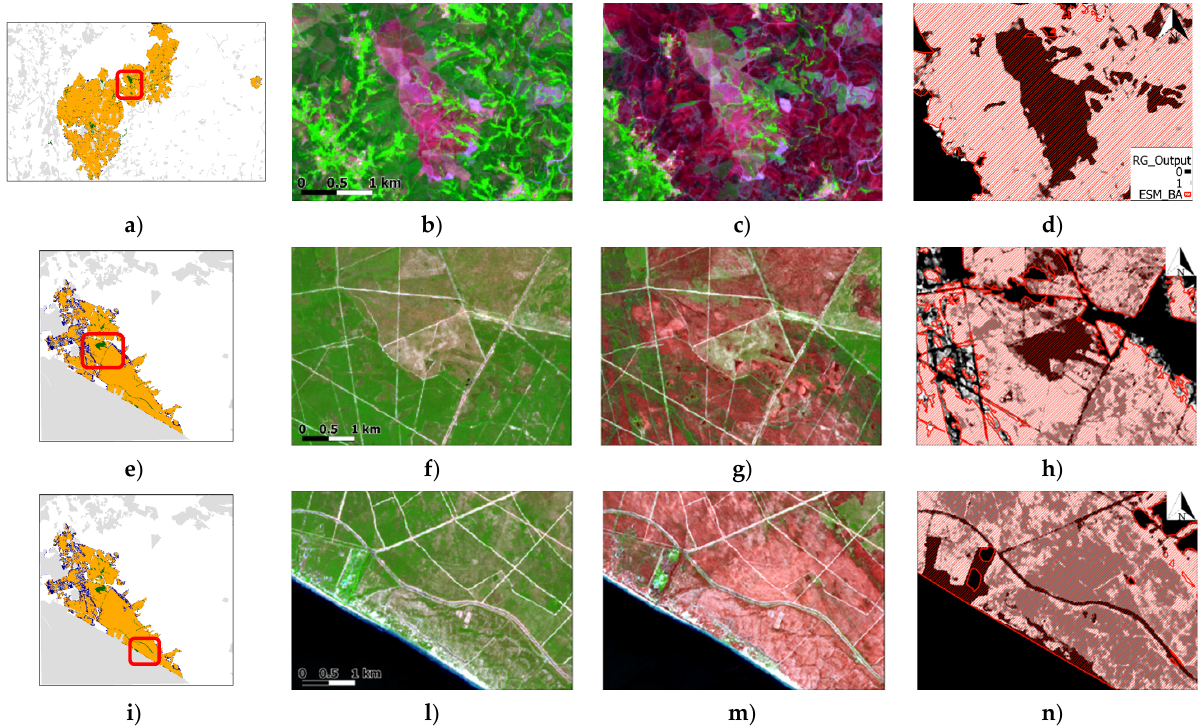
Figure A4. Example of apparent commission errors for the Leiria site, Portugal ( a – d ): pre-fire S2 image (4 June 2017, b ), post-fire S2 image (4 July 2017, c ) and burned areas from RG and EMS ( d ). Examples of commission errors in the Huelva site, Spain ( e – n ): pre-fire S2 image (11 June 2017, f , l ), post-fire S2 image (1 July 2017, g , m ) and burned areas from RG and EMS ( c ). S2 RGB are false color composites SWIR-NIR-Red. First column shows the location of the zoom areas and the last column RG classification (white to black background) and EMS reference perimeters (red line patterns).